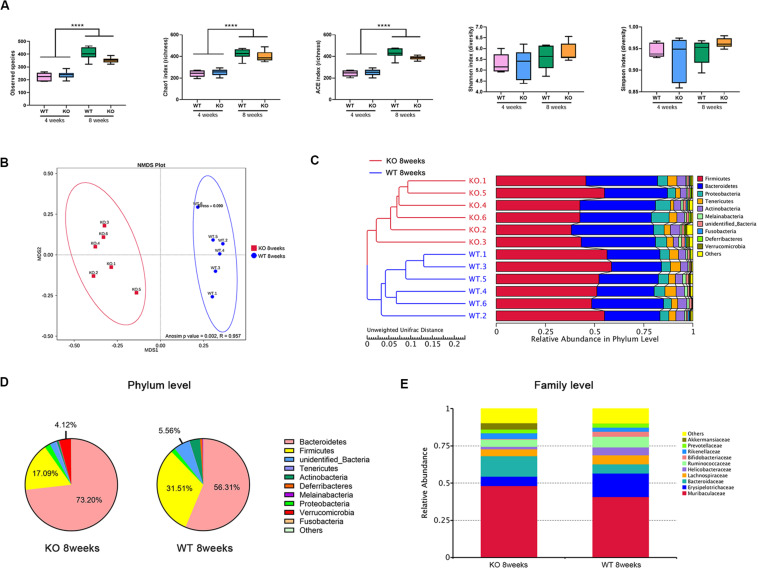
Loss of LanCL1 induces an altered composition of the gut microbiota at 8 weeks of age. (A) The box-plot of alpha diversity indices including the observed species, Chao1, ACE, Shannon, and Simpson indexes. (B) Non-metric multi-dimensional scaling (NMDS) based on the Bray-Curtis distance presents the relationship between the microbial profiles of the two groups at 8 weeks of age. NMDS has good reliability when stress <0.2. The R-value of the Anosim analysis is in the interval (–1, 1). R-value > 0 indicates that the differences between groups were significant. R-value < 0 indicates that the difference within groups is greater than the difference between groups. (C) The unweighted pair-group method with arithmetic mean (UPGMA) based on the Unweighted UniFrac distance was used to determine the degree of similarity between the gut microbiota of WT and KO mice at 8 weeks of age. (D) Fan diagram showing the relative abundance of bacterial 16S rRNA genes classified at the phylum level. (E) The bacterial compositions of different communities at the family level. Taxa with abundances <1% are included in others. A significant difference (P < 0.05) was determined by one-way ANOVA followed by Tukey’s multiple comparisons test for A. For A through E, n = 6/group.